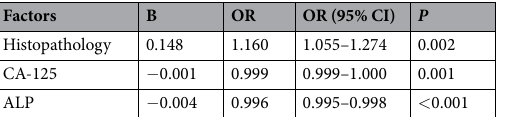
Table 4. The risk factors of bone metastases in patients with lung cancer. CI: confidence interval; OR: odds ratio; B: coefficient of regression; ALP: alkaline